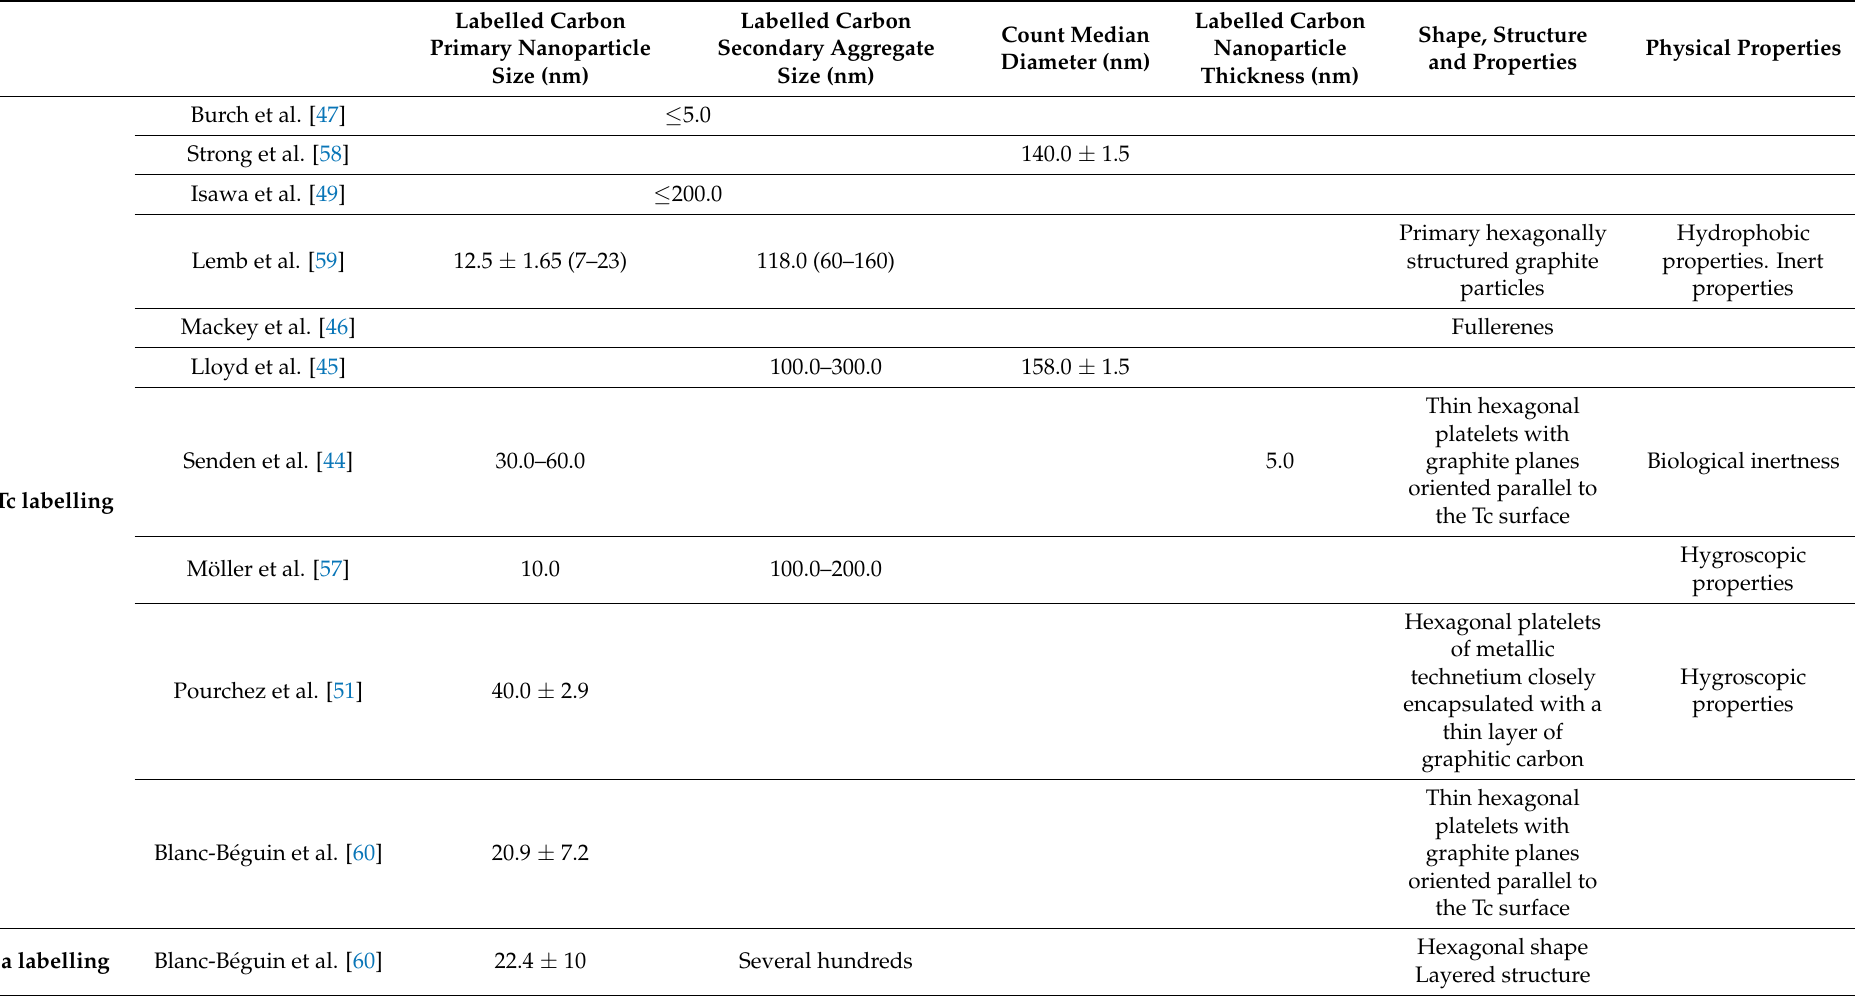
Table 4. 99m Tc and 68 Ga-labelled carbon nanoparticle size, shape and structure according to the